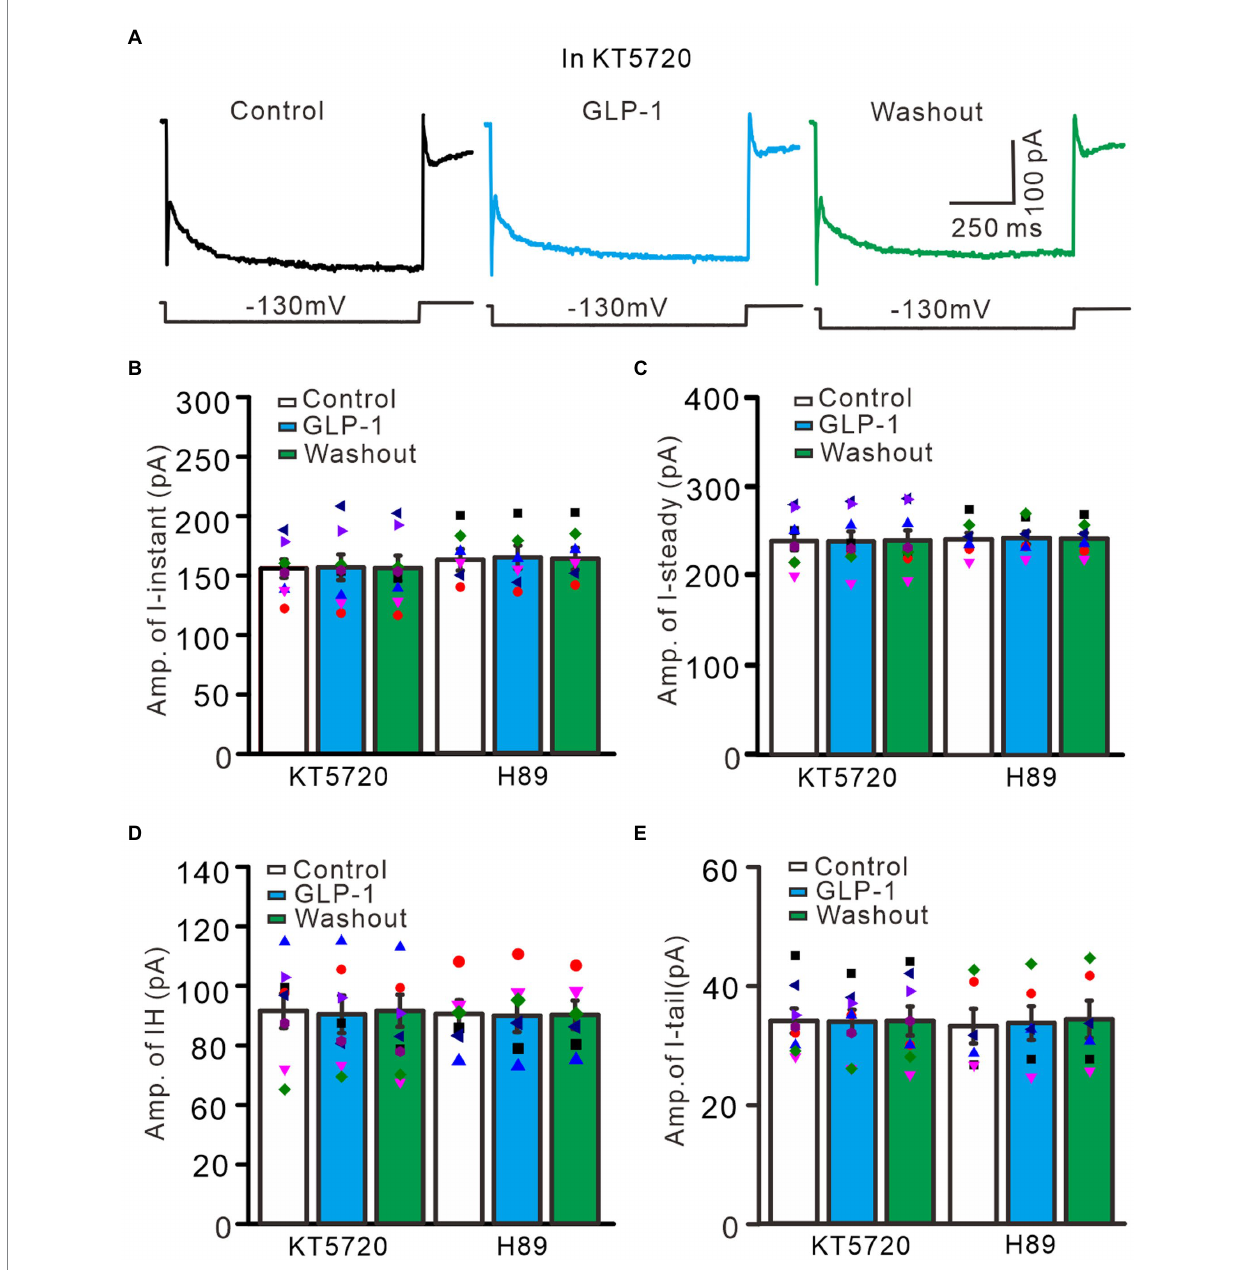
FIGURE 9 Inhibition of PKA, GLP-1 failed to enhance the hyperpolarizing voltage step-elicited membrane currents in PCs. (A) The representative traces showing membrane currents elicited by a hyperpolarizing voltage step ( − 130 mV, 1 s) during treatments with KT5720 (500 nM), KT5720 + GLP-1 (100 nM), and washout of GLP-1. (B,C) Left panel showing the mean (± S.E.M; n = 8 cells) and individual amplitude of I-instant (I-inst.; B ) and I-steady (C) during treatments with KT5720, KT5720 + GLP-1, and washout of GLP-1; Right panel showing the mean (± S.E.M; n = 6 cells) and individual amplitude of I-instant (I-inst.; B ) and I-steady (C) during treatments with H89, H89 + GLP-1, and washout of GLP-1 (Right panel). (D,E) Left panel showing the mean (± S.E.M; n = 8 cells) and individual amplitude of IH (D) and IT (E) during treatments with KT5720, KT5720 + GLP-1, and washout of GLP-1; Right panel showing the mean (± S.E.M; n = 6 cells) and individual amplitude of IH (D) and IT (E) during treatments with (left panel); H89, H89 + GLP-1, and washout of GLP-1 (Right